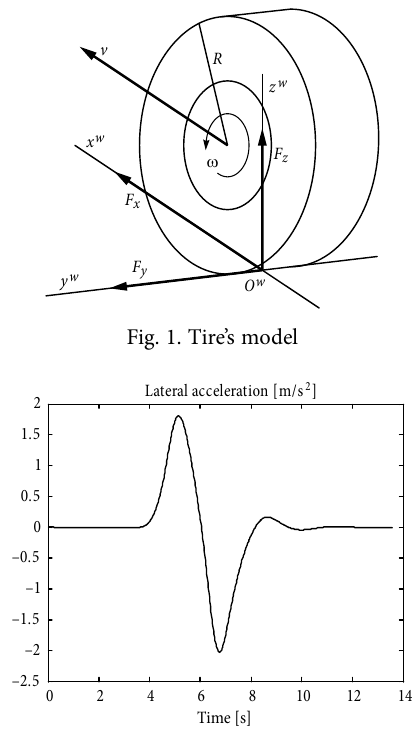
Fig. 2. Lateral acceleration – chicane Chicane: front right